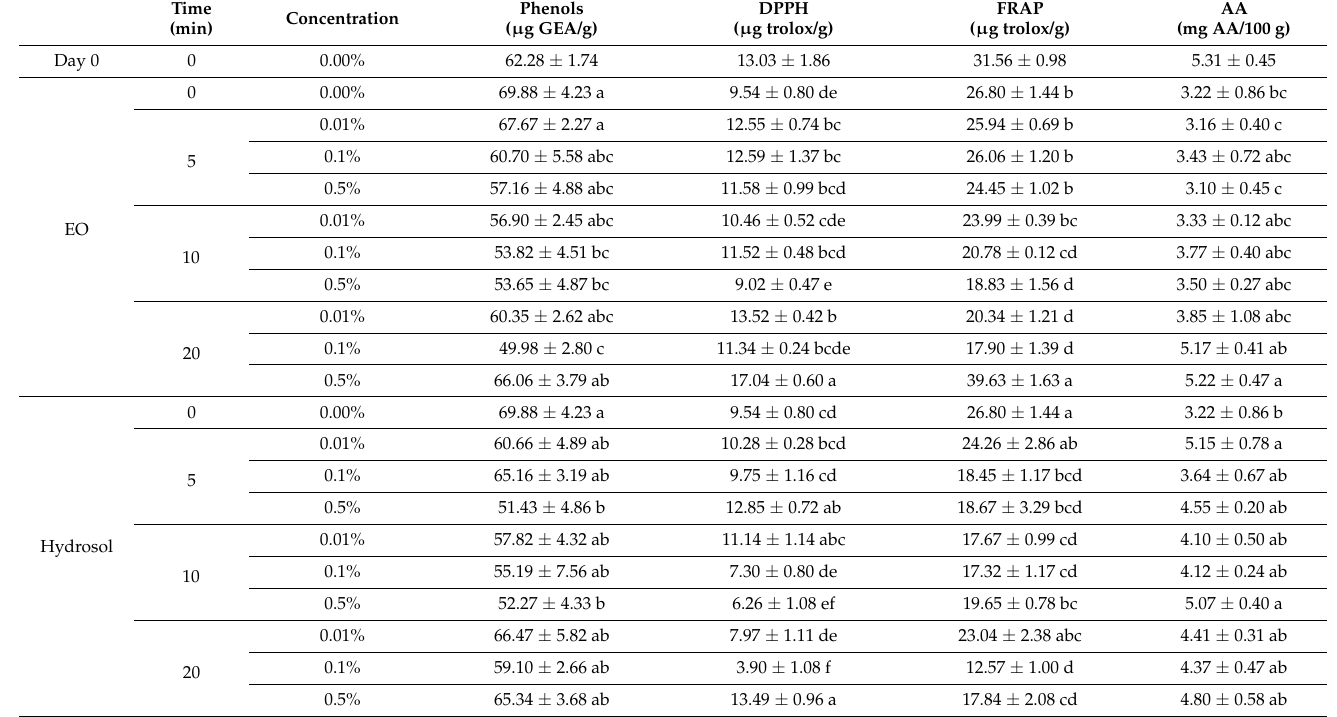
Table 6. Screening of O. dubium EO and hydrosol application effects on fresh cucumber phenols, antioxidants (DPPH, FRAP) and ascorbic acid (AA) content when stored at 11 ◦ C for 9 days. Values presented as mean ± standard error of four biological replicates per treatment. Measurements for day 0 refer to the control. In each column and for each treatment (EO and hydrosol), significant differences ( p < 0.05) are indicated with different Latin